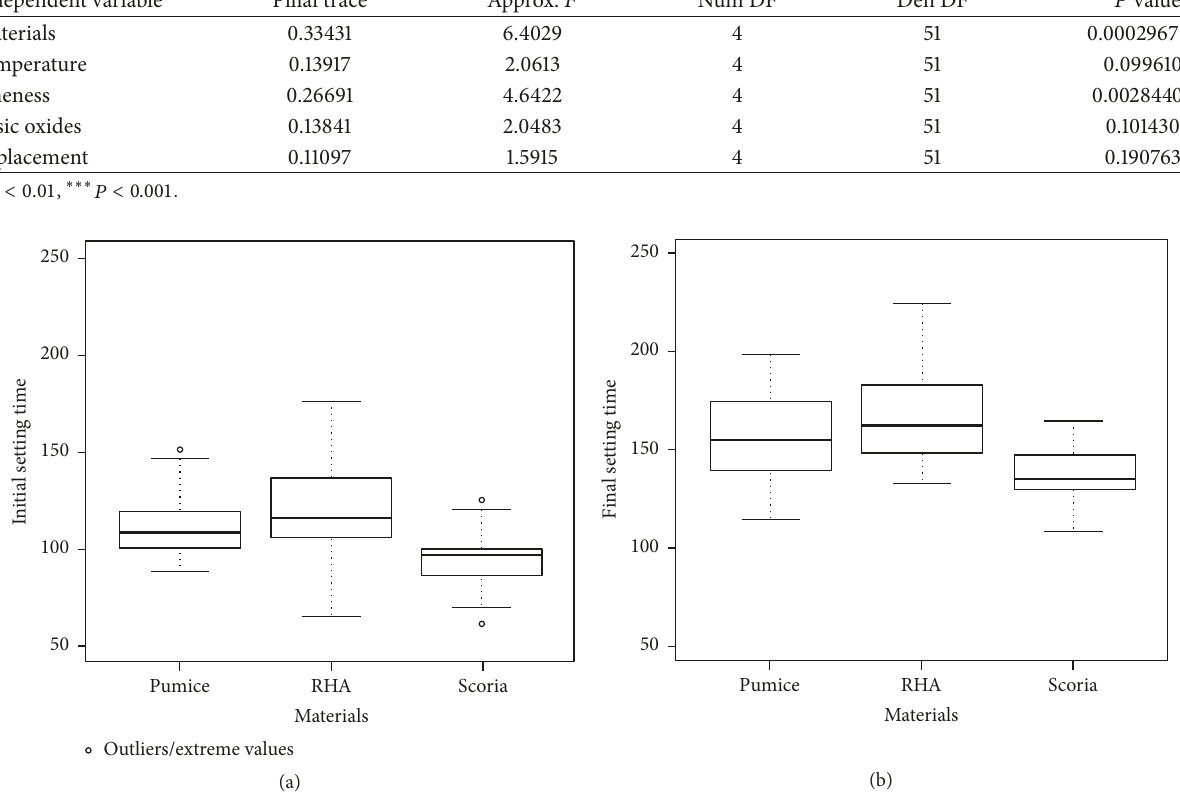
water-cement ratio requirement of between 0.26 and